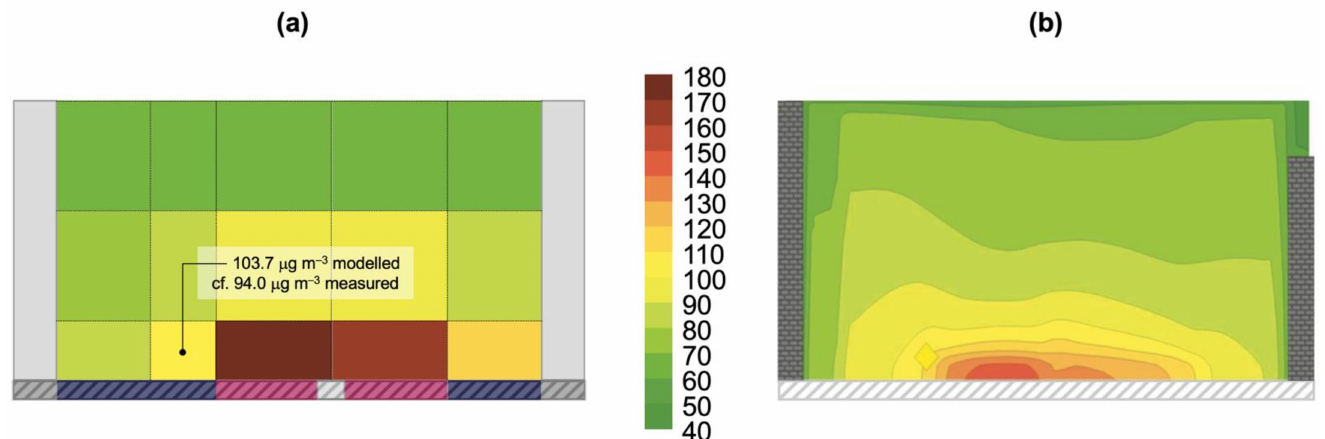
Figure 9. ( a ) Our modelled 2012 annual mean NO 2 ( µ g m − 3 ) beside Marylebone Road, and ( b ) a reproduction of [51]’s Figure 7 (originally published by Taylor & Francis Ltd.: www.tandfonline.com, accessed on 7 June 2021); note, for direct comparison, our reproduction of [51]’s Figure 7 is reflected in the vertical relative to their